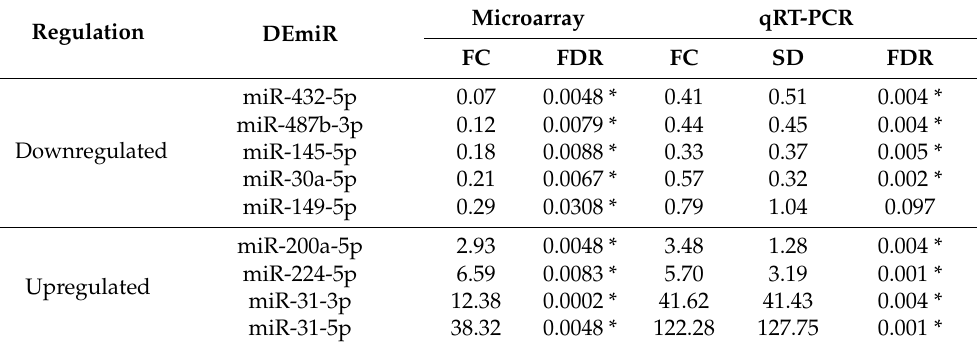
miR-200a-5p 2.93 0.0048 * 3.48 Upregulated